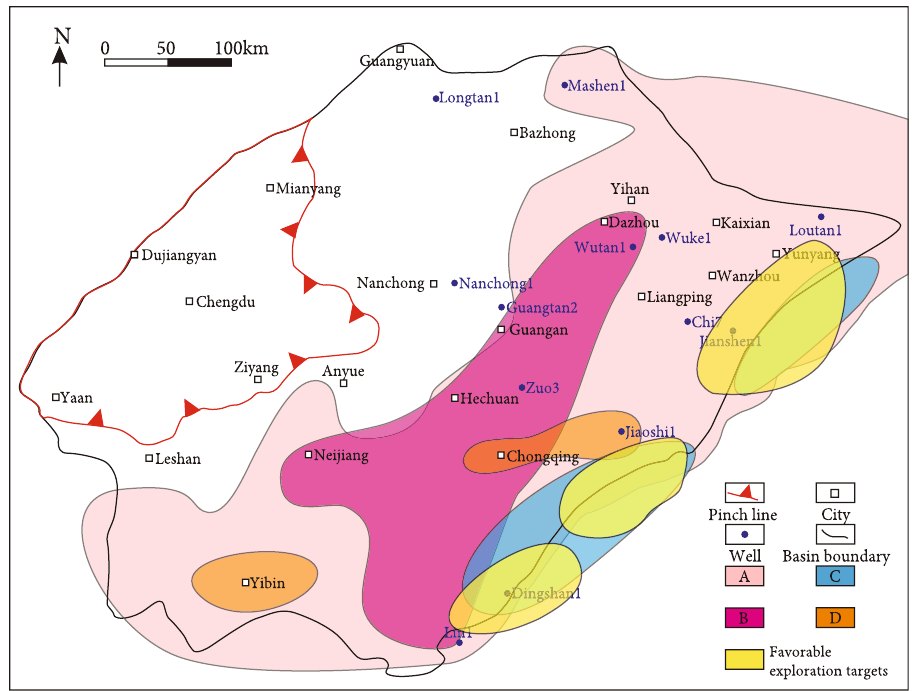
Figure 16: Distribution of favorable exploration zones of the Cambrian DEPS in the Sichuan